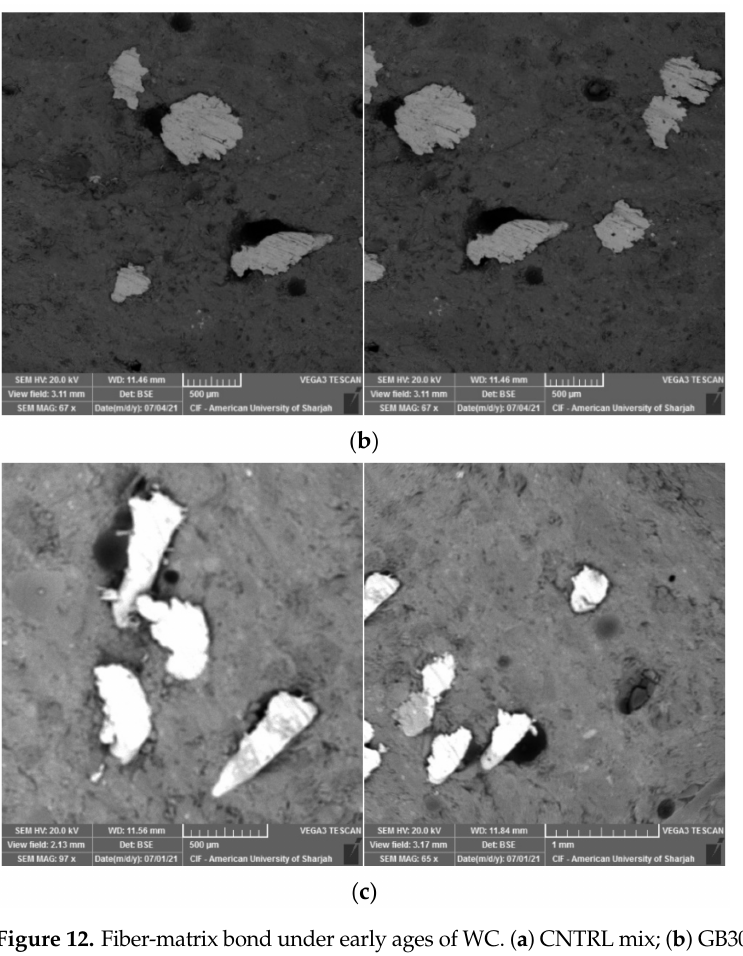
Figure 12. Fiber-matrix bond under early ages of WC. ( a ) CNTRL mix; ( b ) GB30 mix; ( c ) GB15FA15 mix.